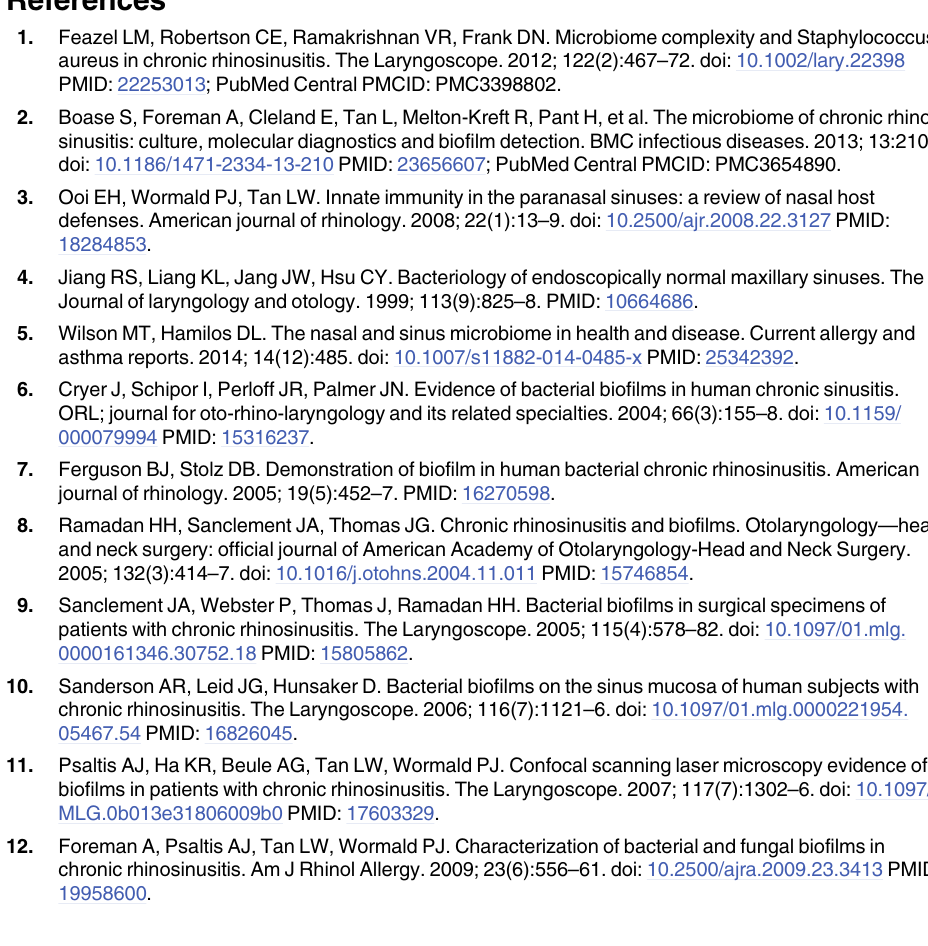
S1 Table. Patients total bacterial abundances for each optimisation method. Replicates (Rep) for each method are shown. S2 Table. Patients total VLP abundances for each optimisation method. Replicates (Rep) for each method are